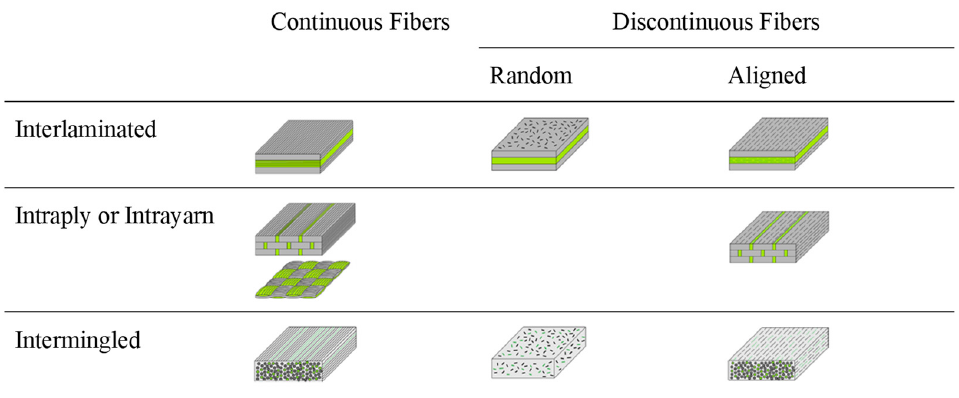
Figure 2. Hybrid fiber structures [28].